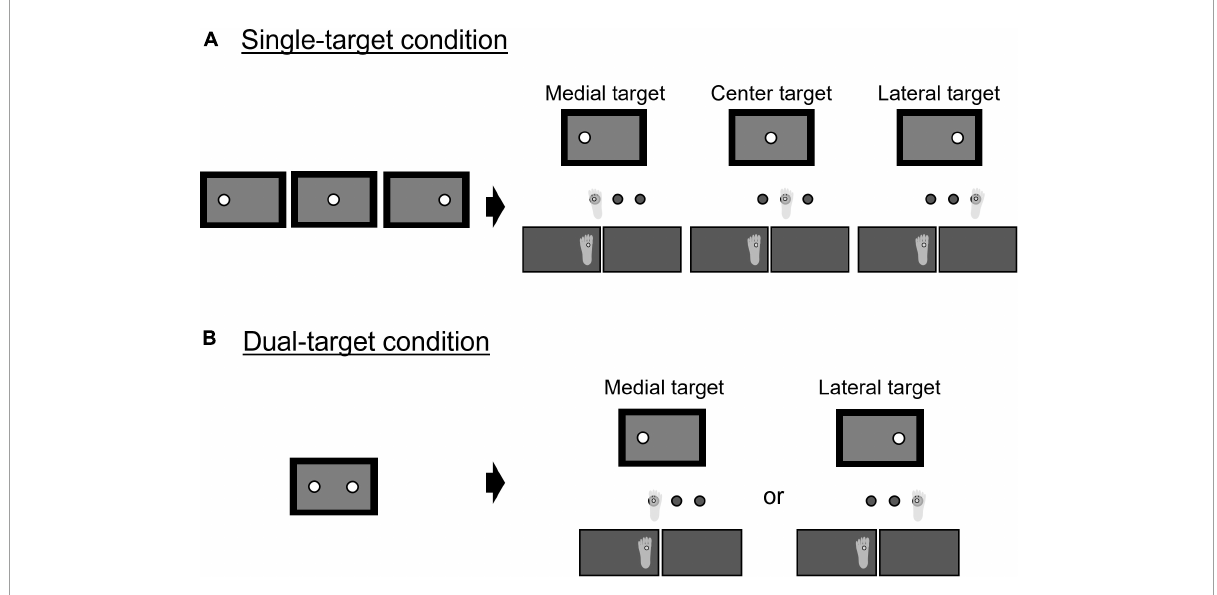
FIGURE3 Illustration of trial types: (A) single-target condition; (B) dual-target